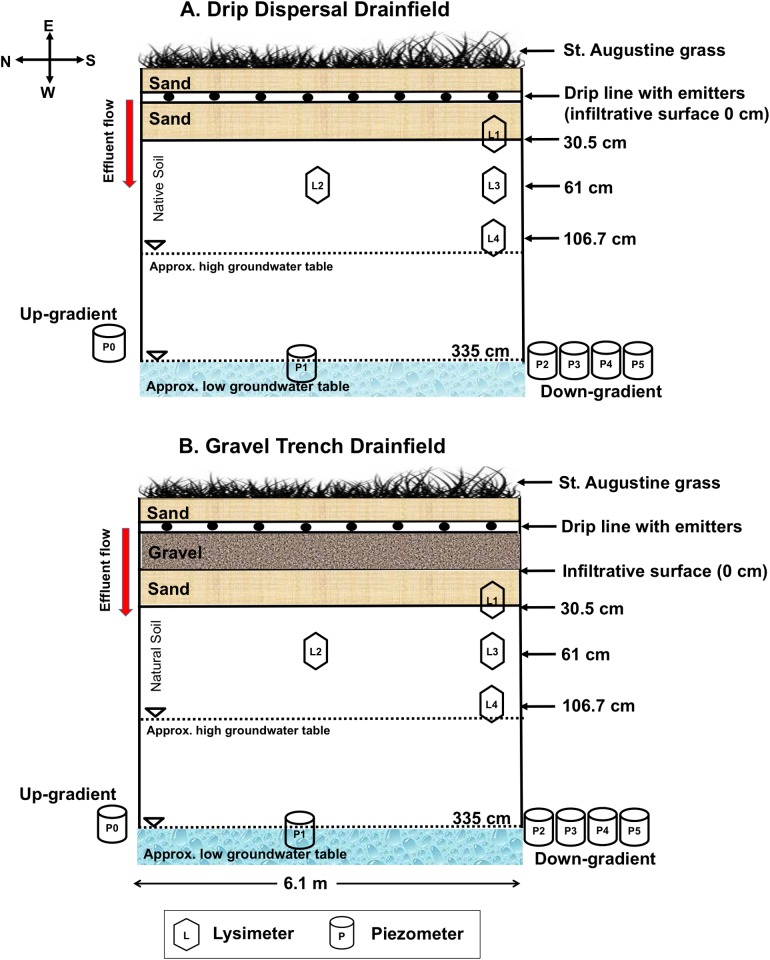
A north-south longitudinal cross-section (not to scale) of the drainfields showing vadose zone and groundwater monitoring instruments: (A) drip dispersal and (B) gravel trench systems.